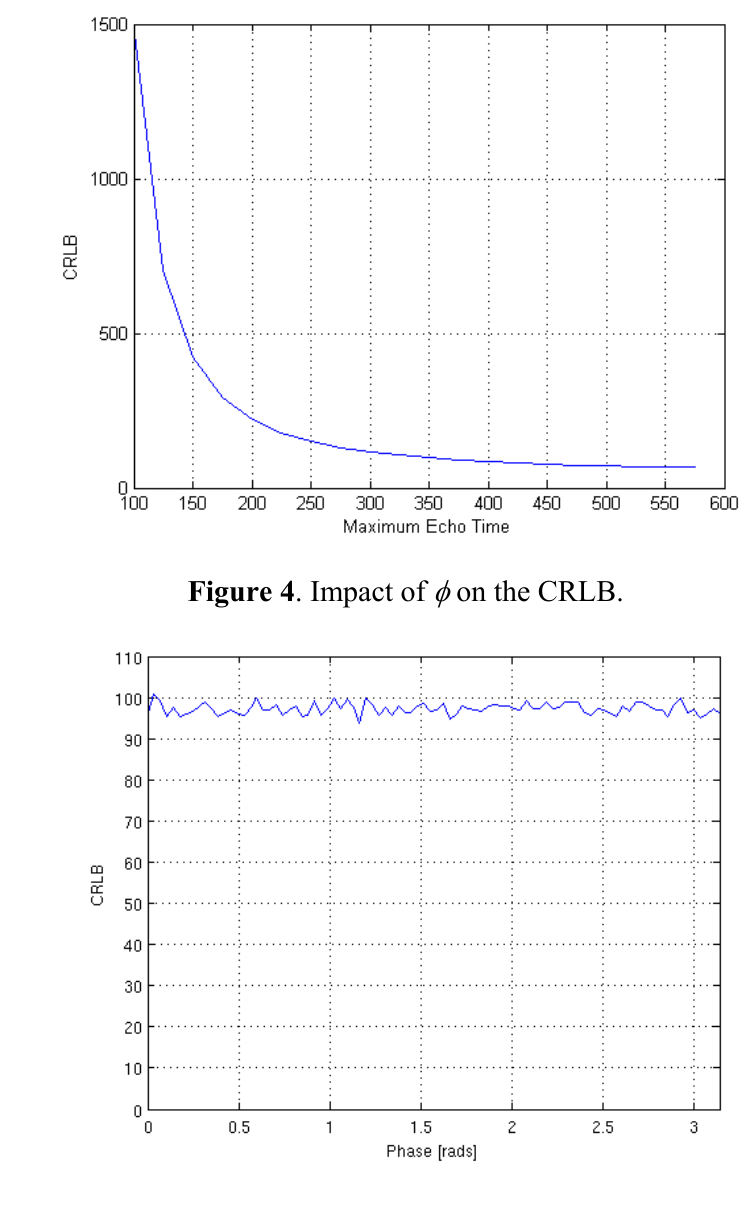
Figure 3 . Impact of different spacing between TE values on the CRLB.